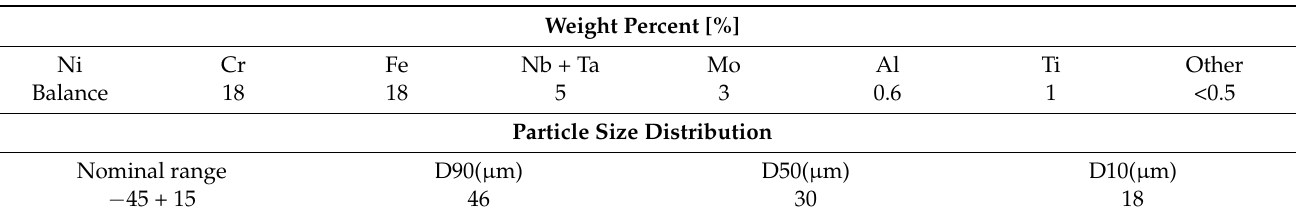
Table 2. Nominal weight percent of Inconel’s 718 chemical composition and its particle size distribu- tion derived from the